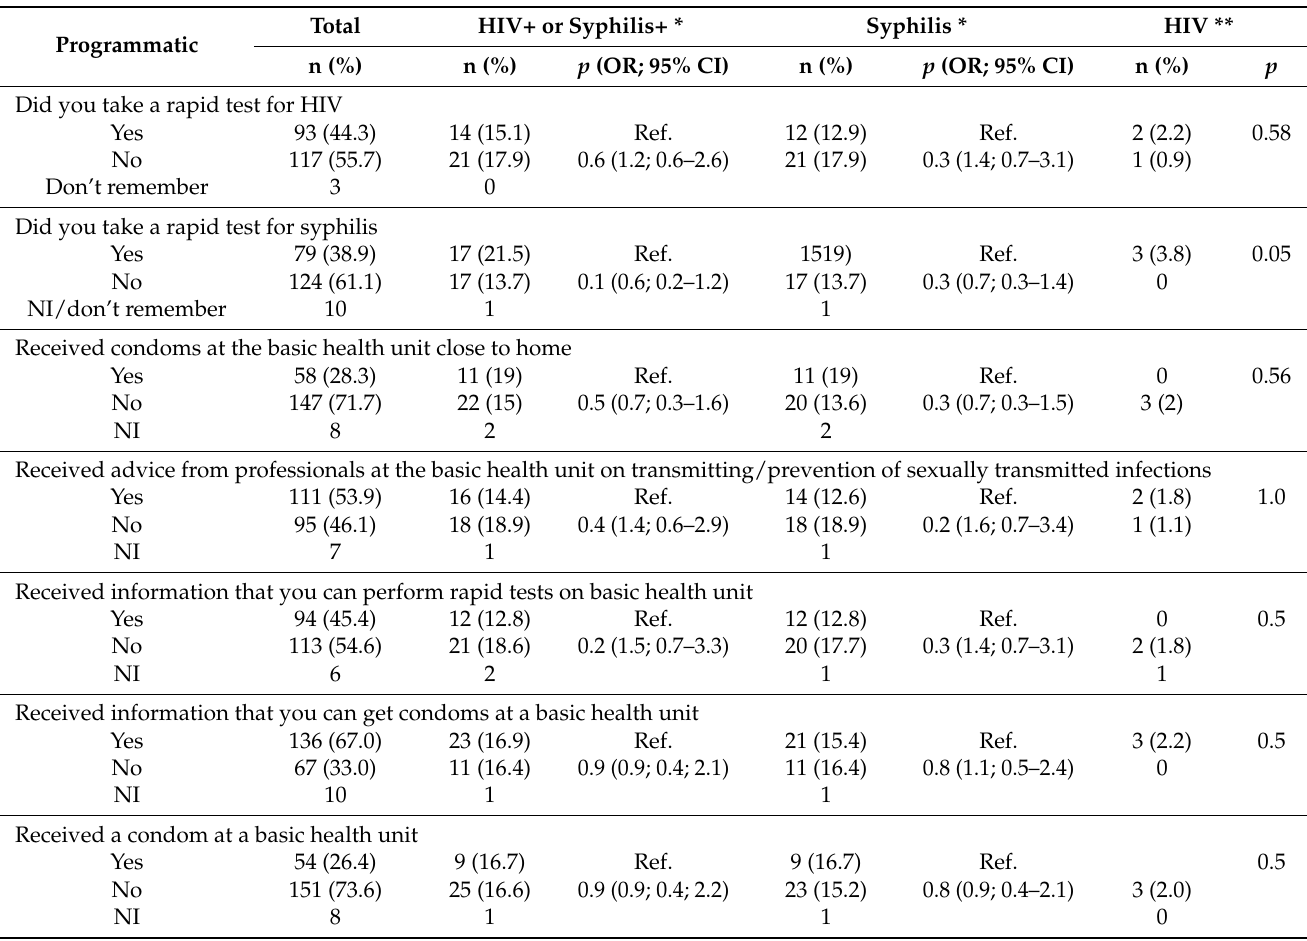
Table 2. Programmatic factors associated with sexually transmitted infections in older people in a subnormal agglomeration in the Brazilian Amazon.